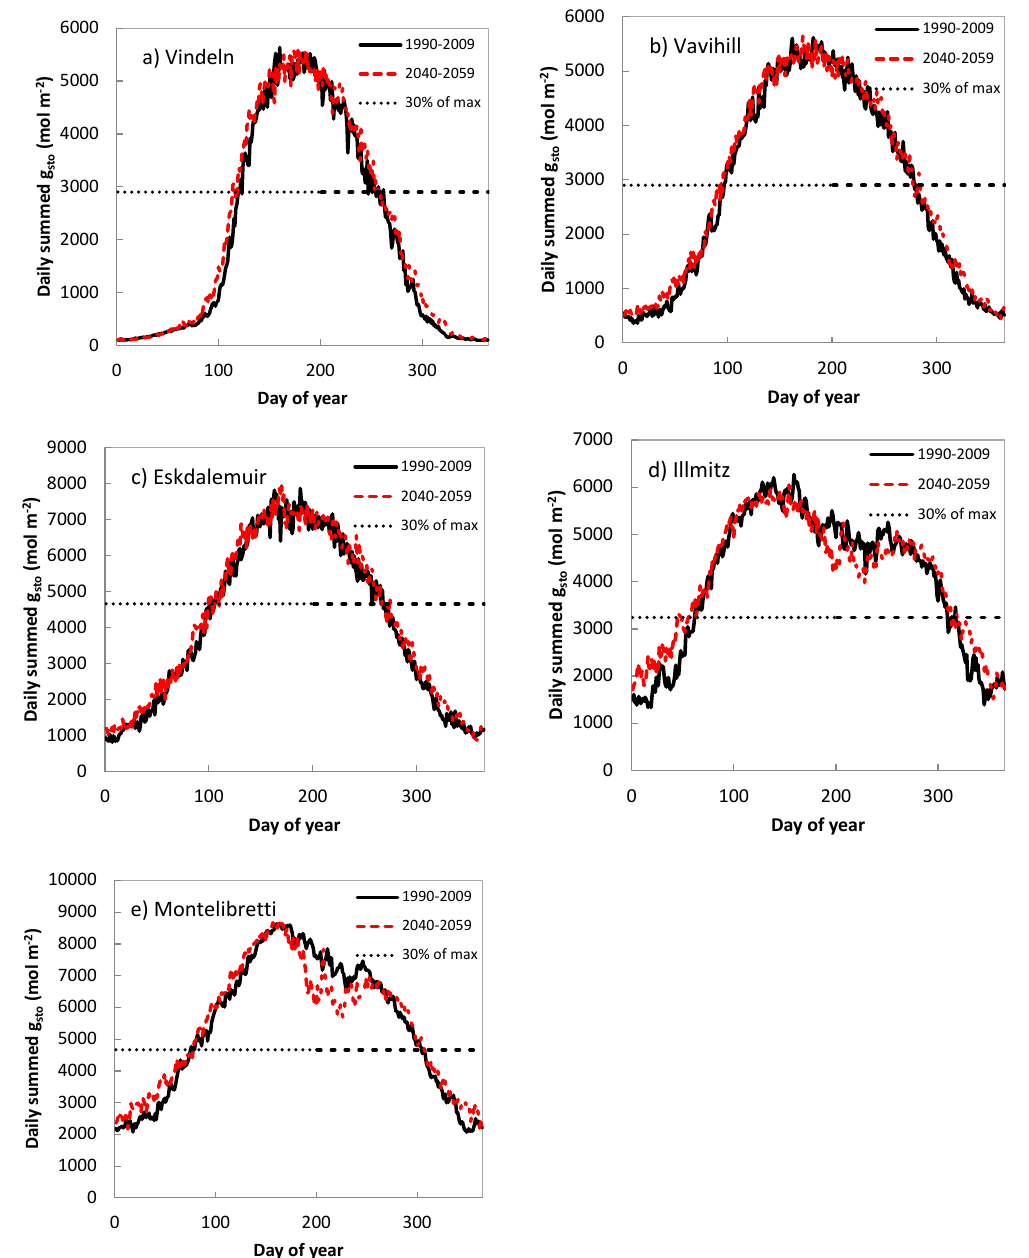
Figure 7. Daily summed stomatal conductance ( g sto ) based on temperature, VPD and light as an average year 1990–2009 and 2040–2059. At (a) Vindeln and (b) Vavihill the stomatal conductance was calculated based on the northern European Norway spruce parametrisation, at (c) Eskdalemuir the Atlantic Central European Scots pine parametrisation, at (d) Illmitz the Continental Central European Norway spruce parametrisation and at (e) Montelibretti the Mediterranean Europe Holm oak parametrisation. The dotted line represents the 30% threshold of the theoretically maximum daily summed g sto , used to define the O 3 sensitive period at each